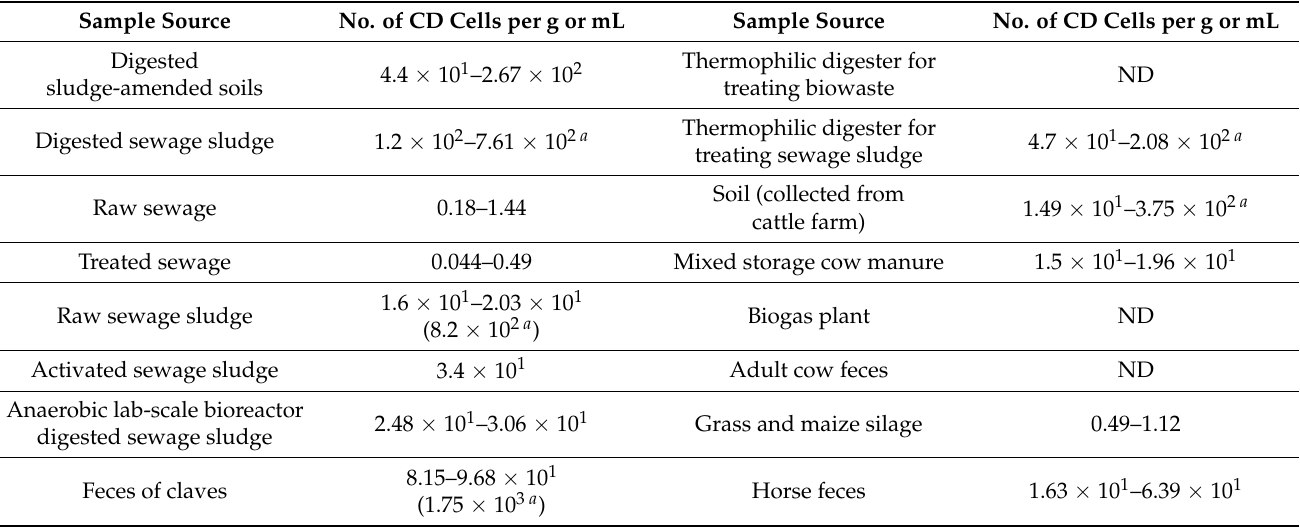
Table 3. Quantification of environmental C. difficile from fecally contaminated environmental samples.